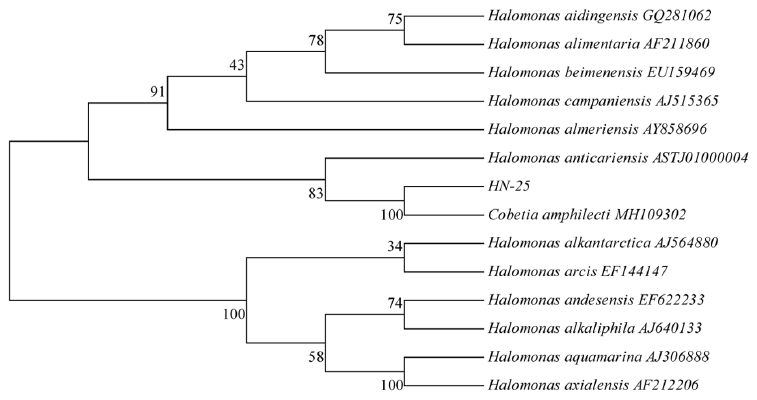
Figure 1. The 16s rDNA phylogenetic tree of strain HN-25.